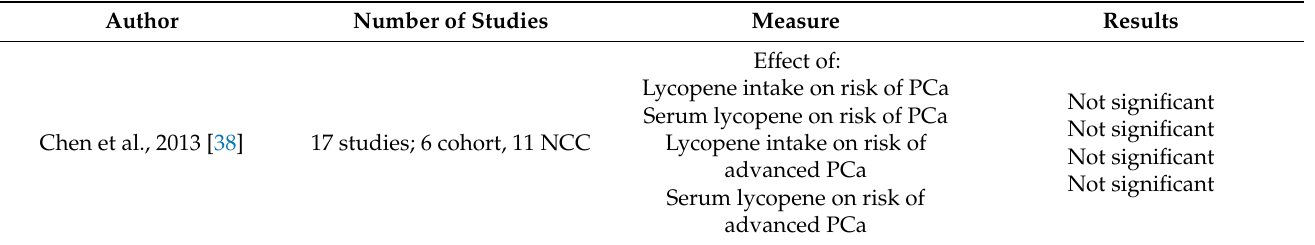
Table 1. Characteristics of meta-analyses assessing carotenoids’ effect on prostate cancer